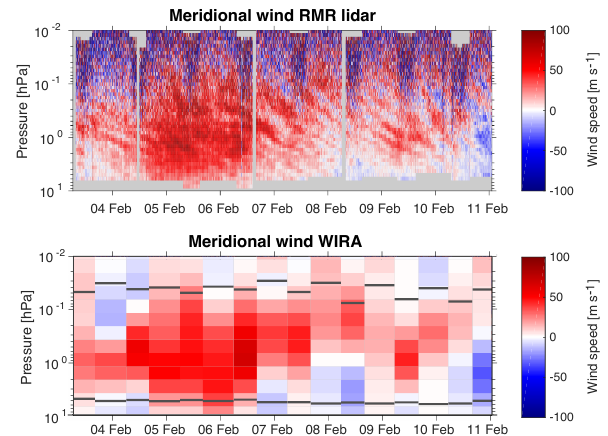
Figure 3. As Fig. 2 but for the meridional wind component.